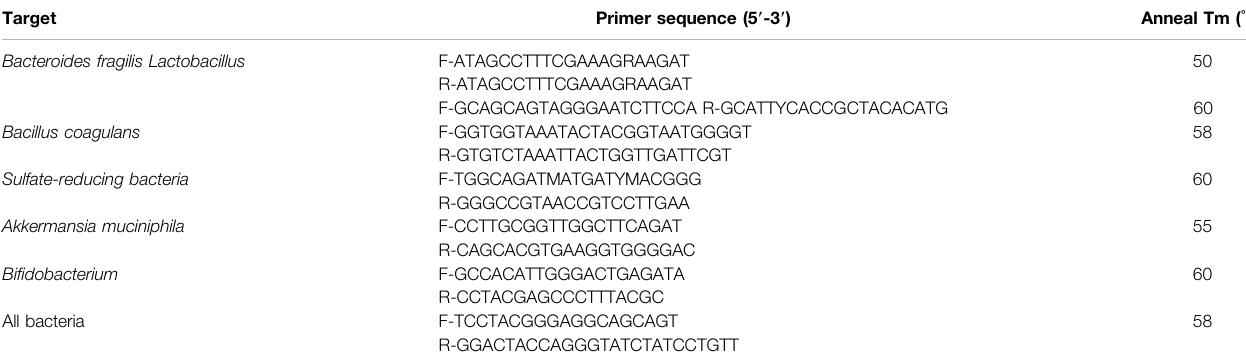
Figure S1 . Fingerprint similarity of 10 batches of SND is shown in Supplementary Table S1